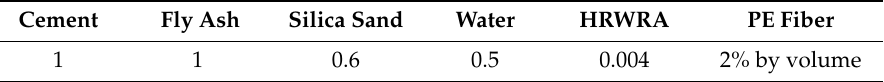
Table 1. Mixture Proportion of ECC Mixture (by weight).